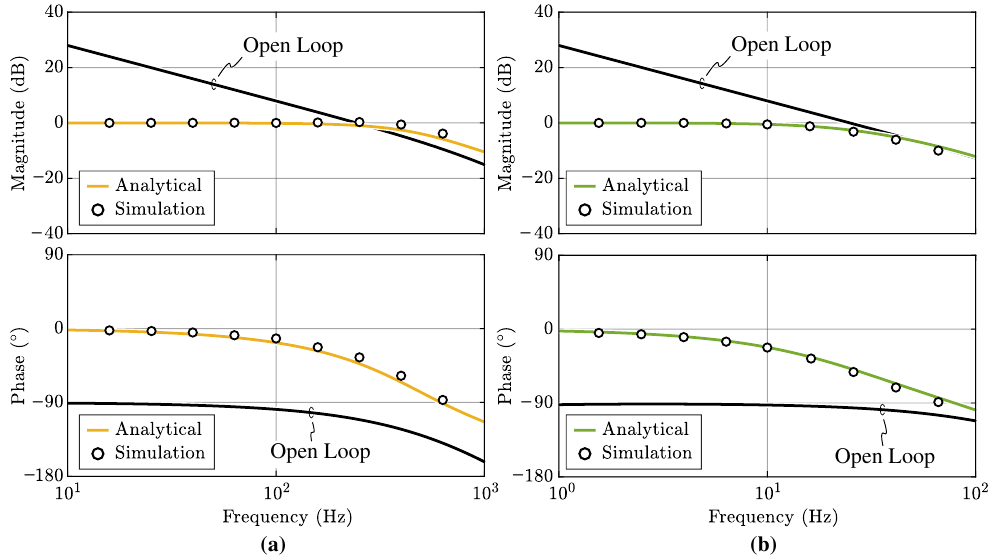
Figure 14. Analytically derived and simulated closed-loop transfer functions of the DC/DC output current controller ( a ) and output voltage controller ( b